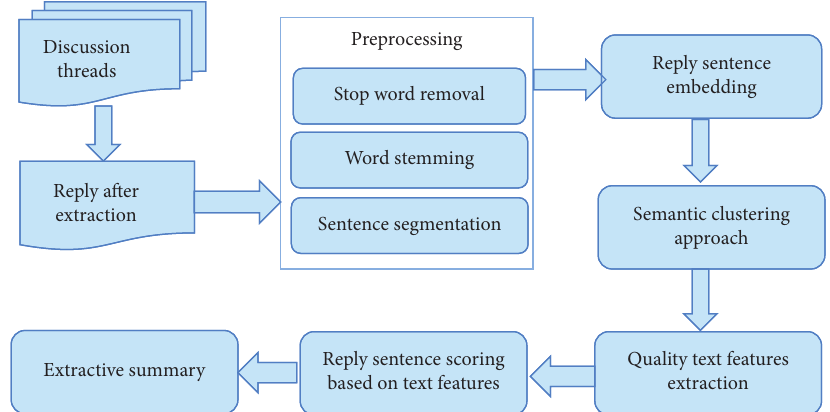
Figure 1: Proposed approach for discussion thread